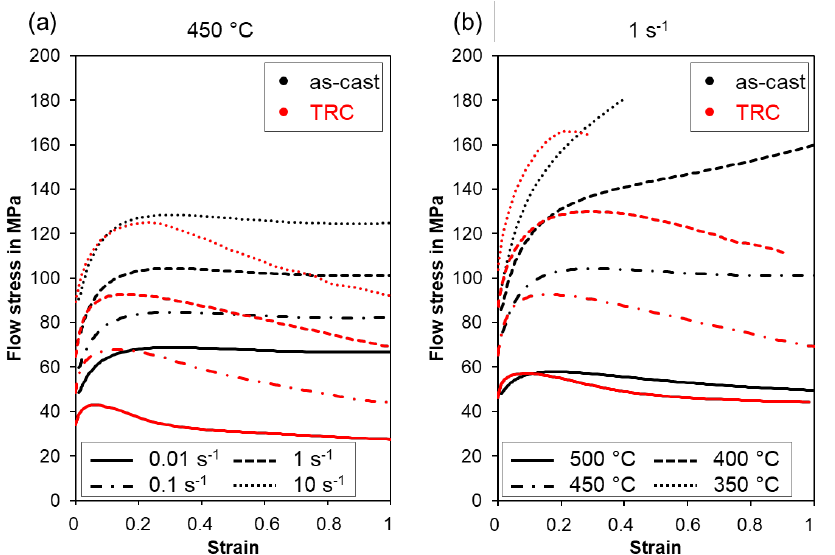
Figure 5. Flow stress-strain curves of the homogenized Mg-6.8Y-2.5Zn-0.4Zr alloy after conven- tional and twin-roll casting, deformed at ( a ) a temperature of 450 °C and different strain rates (0.01, 0.1, 1, 10 s − 1 ), and at ( b ) a strain rate of 1 s − 1 and different temperatures (350, 400, 450, 500 °C)